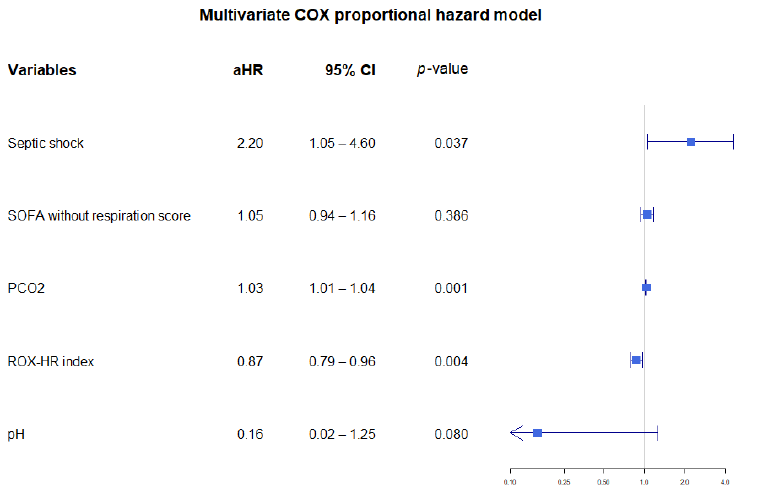
Figure 4. Multivariate cox proportional hazard model using the ROX-HR index. Abbreviations: aHR = adjusted hazard ratio, CI = confidence interval, SOFA = sequential organ failure assessment, PCO 2 = partial pressure of carbon dioxide.